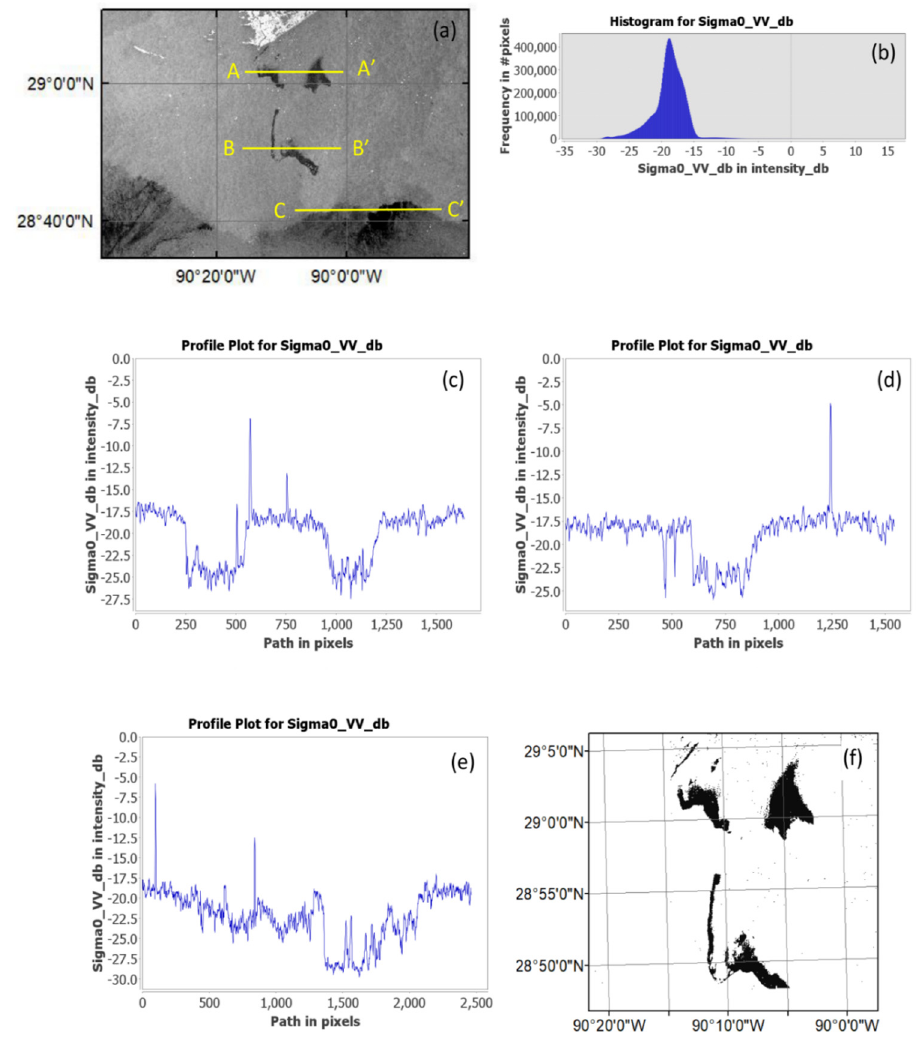
Figure 3. ( a ) The data acquired from Sentinel-1A satellite for the oil spill on 10 September 2021, ( b ) Sentinel-1 image histogram, ( c ) AA’ cross-section profile plot of Sentinel-1 images, ( d ) BB’ cross- section profile plot of Sentinel-1 images, ( e ) CC’ cross-section profile plot of Sentinel-1 images, ( f ) Sentinel-1A for the oil spill ML classification results.